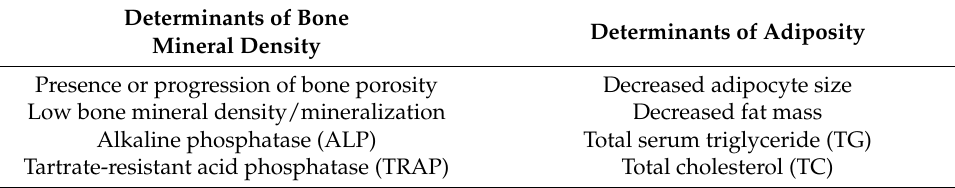
Table 1. Features that are determinants of bone mineral density and